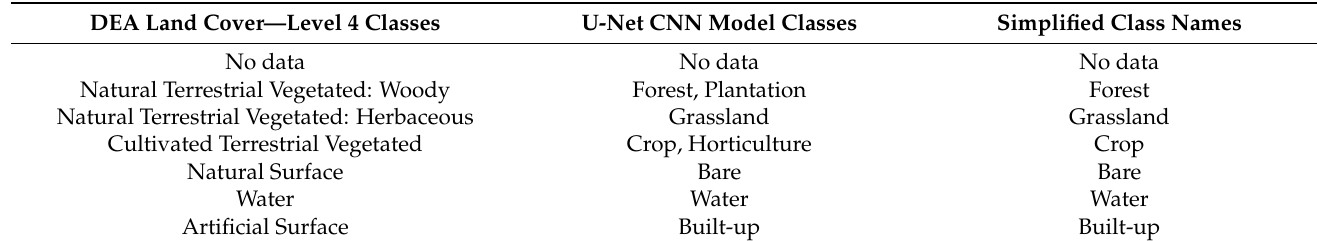
Table 3. Class correspondence table for DEA Land Cover level 4 to U-Net CNN land cover.